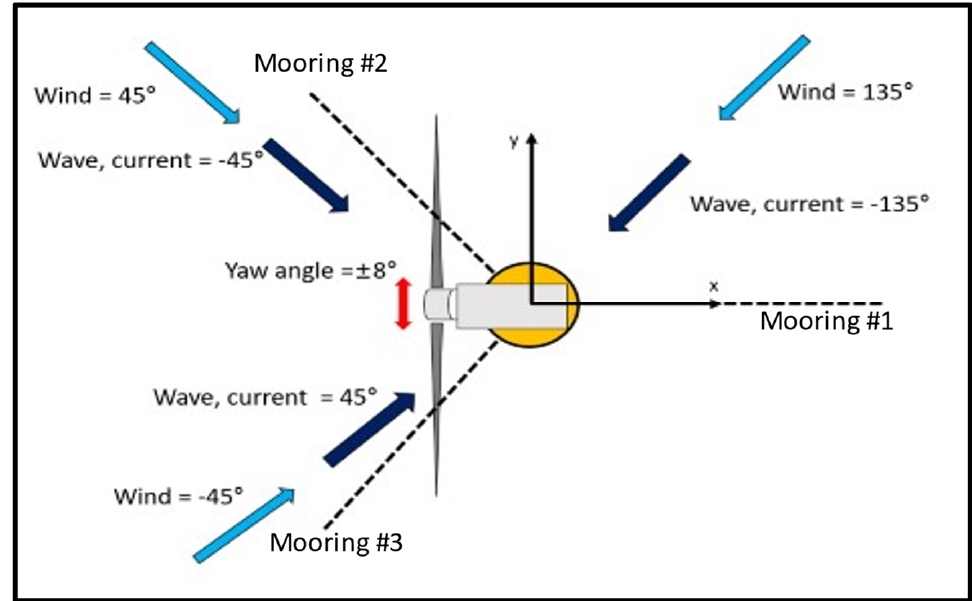
Figure 7. Co-directional conditions of wind, wave, and current.